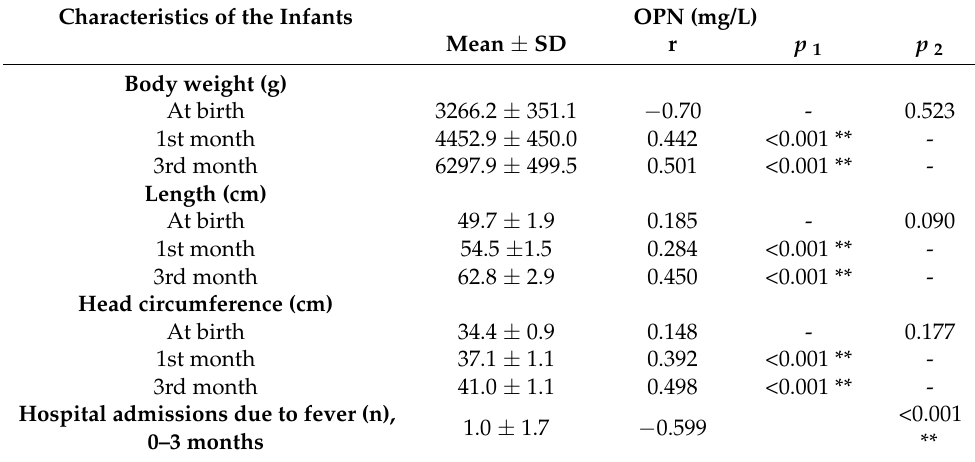
Table 5. Anthropometric measurements of infants at birth, and at the 1st and 3rd months, the number of hospital admissions of the baby due to febrile illness from birth to 3rd month of life and their correlations to breast milk OPN (Osteopontin)